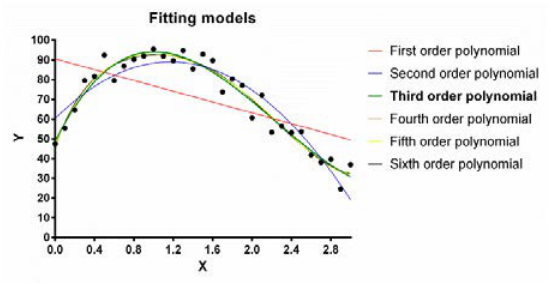
Fig. 4. Simulated data (31 points) and curves of the fitting models (six fitted polynomial curves of increasing order, from 1 (straight line) to 6).